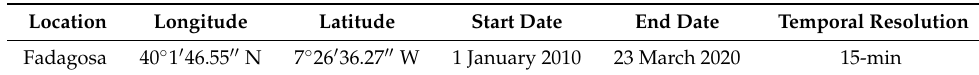
Figure 5. Map of Fadagosa region. Table 2. Details of the location.